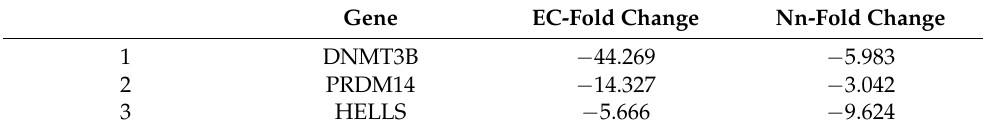
Table 8. Genes in epigenetic category that are downregulated in both endothelial and neural cells. Gene EC-Fold Change Nn-Fold Change 1